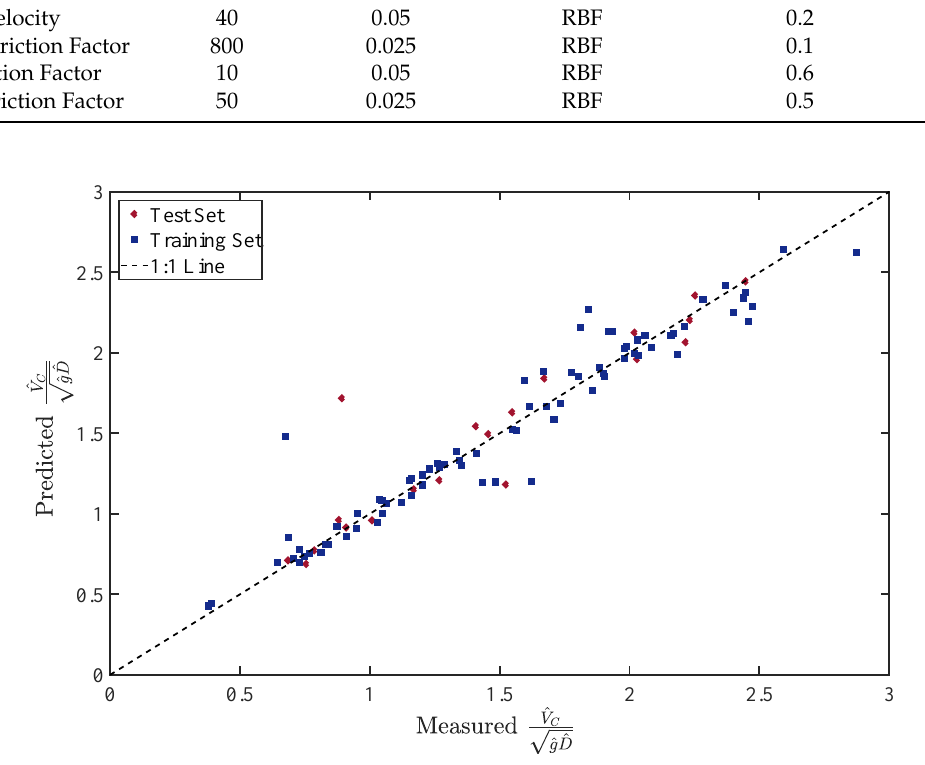
Figure 6. Experimentally measured vs. predicted results of the dimensionless critical velocity for training and test sets.